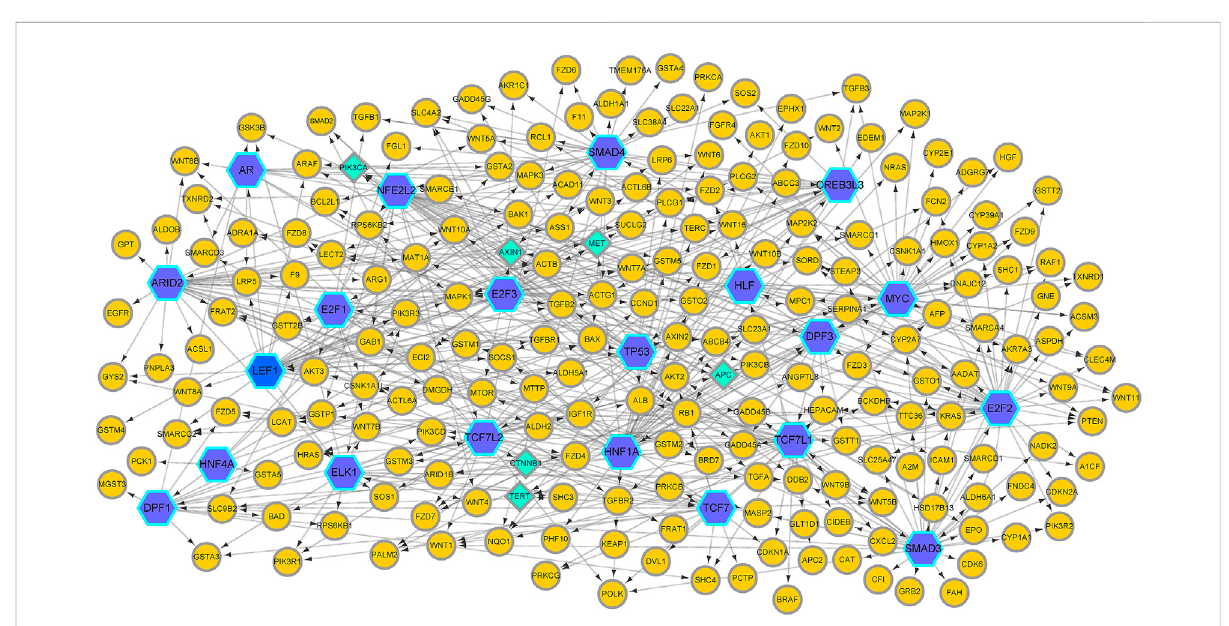
FIGURE 4 The HCC GRN reconstructed by GreyNet. In the network, the larger blue hexagon nodes represent TFs. The circle orange nodes represent the target genes. The diamond green nodes represent some elite disease genes in